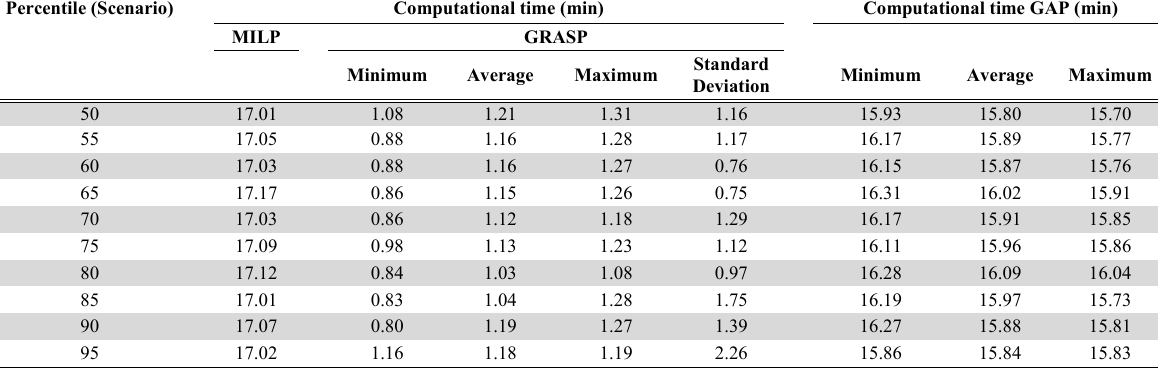
Computational time of MILP and GRASP for each scenario Percentile (Scenario)